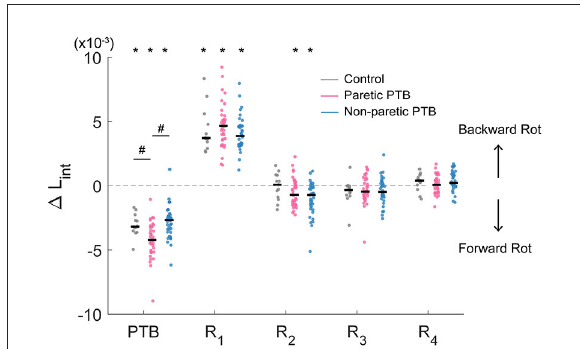
FIGURE4 Median integrated angular momentum in the sagittal plane over the step cycle relative to the corresponding pre-perturbation step ( 1 L int ) for all participants (N 38 stroke participants and = N 13 neurotypical participants). Each dot represents one = participant. Black horizontal lines indicate the median across participants. Steps alternated between paretic and non-paretic for stroke participants. PTB, Perturbation step; R, Recovery step. The asterisks on top of the boxplots indicate whether the difference in L int from the pre-perturbation step was significantly different from zero (*p < 0.05) and the # indicated that the 1 L int was different between groups. Note that for people post-stroke, if the non-paretic leg was perturbed, the R 1 steps were paretic, and Pre-PTB steps and PTB steps were non-paretic and vice versa for the paretic